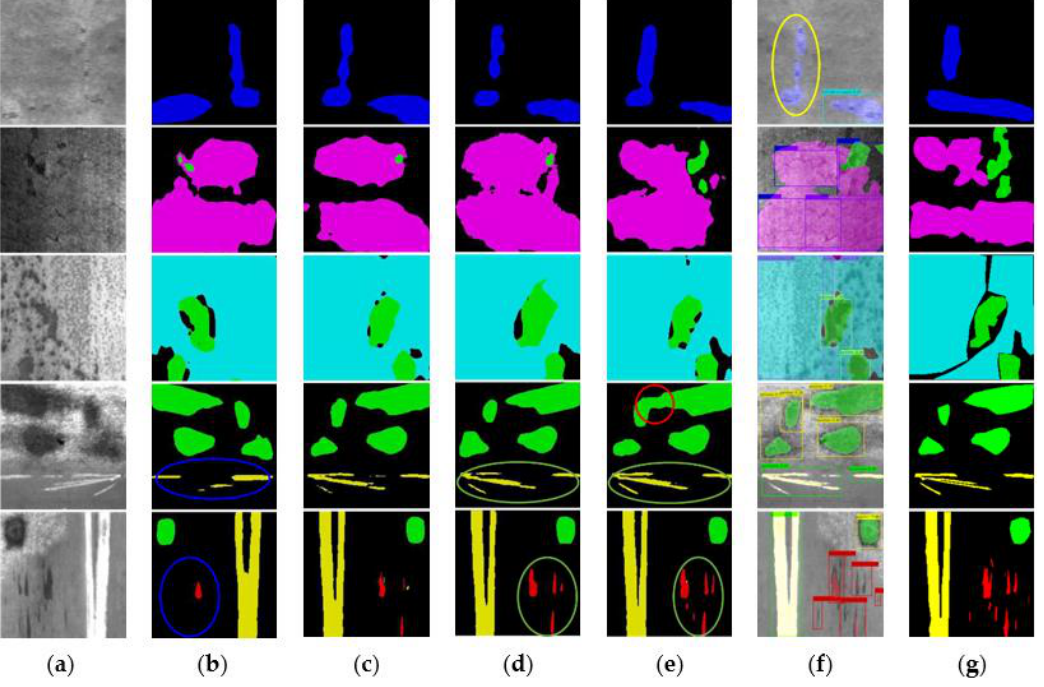
Figure 5. Comparison of segmentation results. ( a ) Original image. ( b ) PSPnet. ( c ) Deeplabv3+. ( d ) Hrnet. ( e ) Unet. ( f ) Ours. ( g ) Ground truth. The colored circles in the figure show false detections.